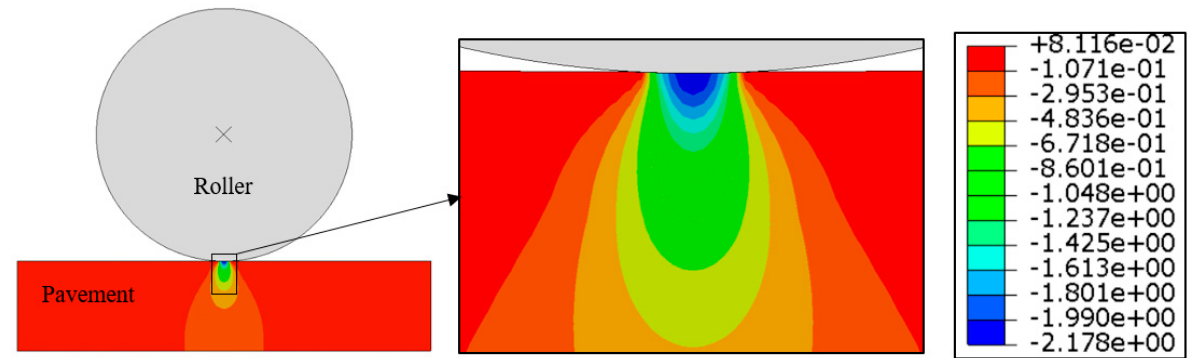
Figure 17. Vertical compressive stress contour under vibratory compaction and an asphalt mixture modulus of 100 MPa.